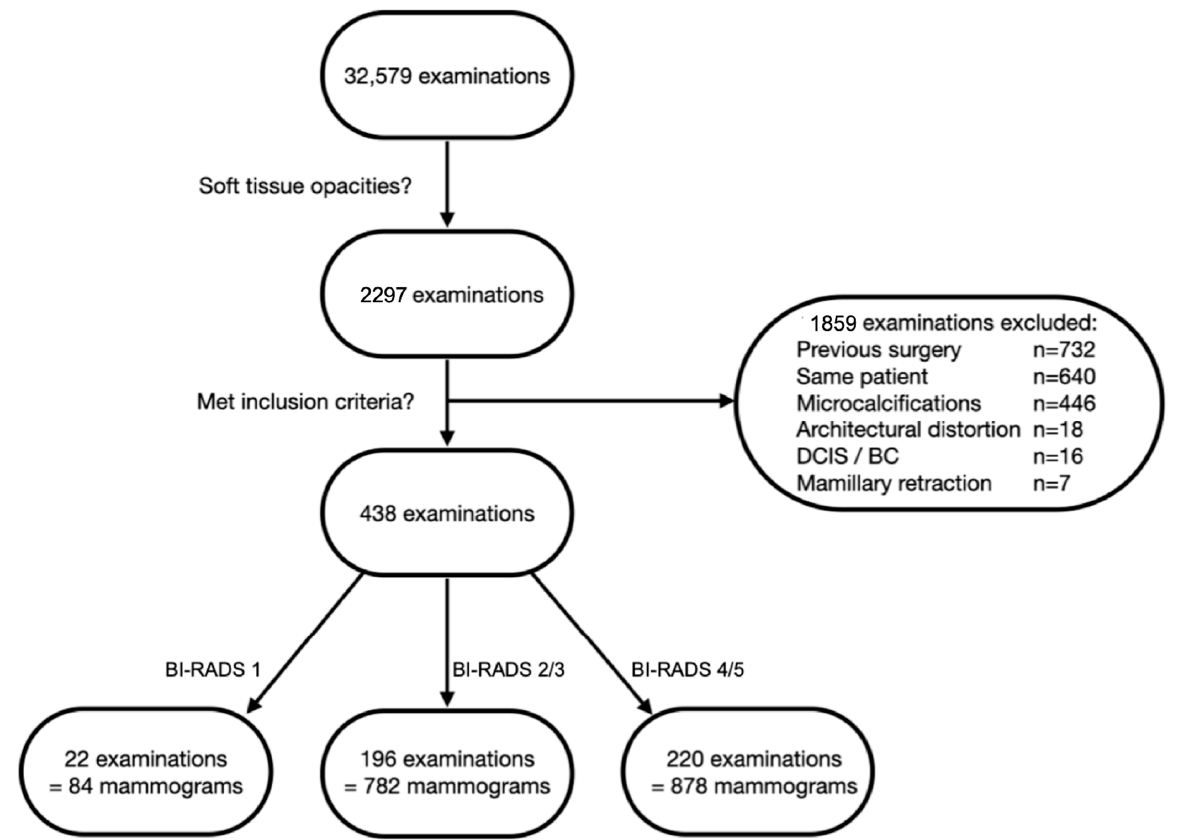
Figure 1. Flowchart depicting patient selection process. Only examinations depicting soft tissue opacities were included. Examinations of women with previous surgery, diagnosed DCIS or breast cancer (BC) on the side examined and examinations from the same patient were excluded. Soft tissue opacities with associated features, e.g., microcalcifications, architectural distortion or mamillary retraction, were excluded.